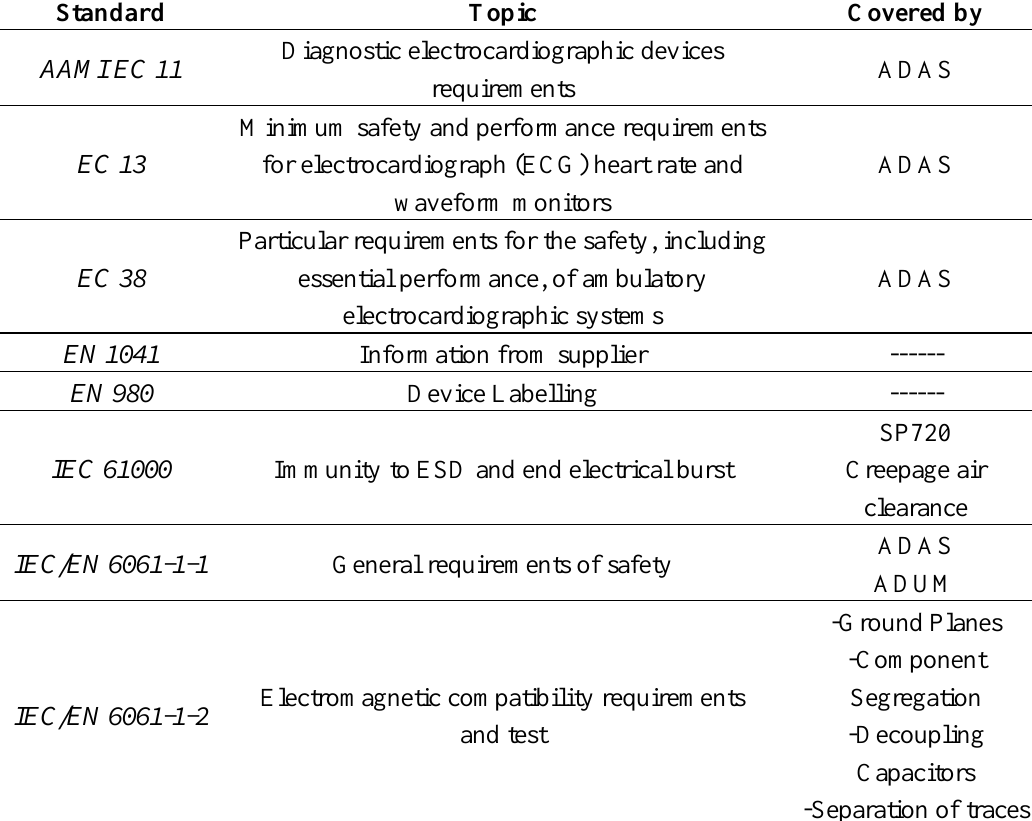
Table 3. Related standards and compliance of current